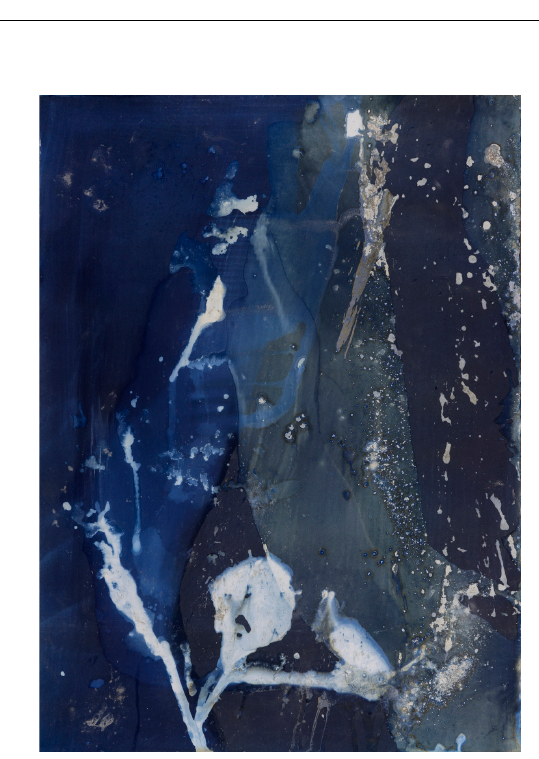
Figure 3: Jonathan Marquis in the field, making a cyanotype for Downwaste , 2019. Courtesy of Jonathan Marquis. Downwaste gallery available at: http://www.jonathanmarquis.com/downwaste